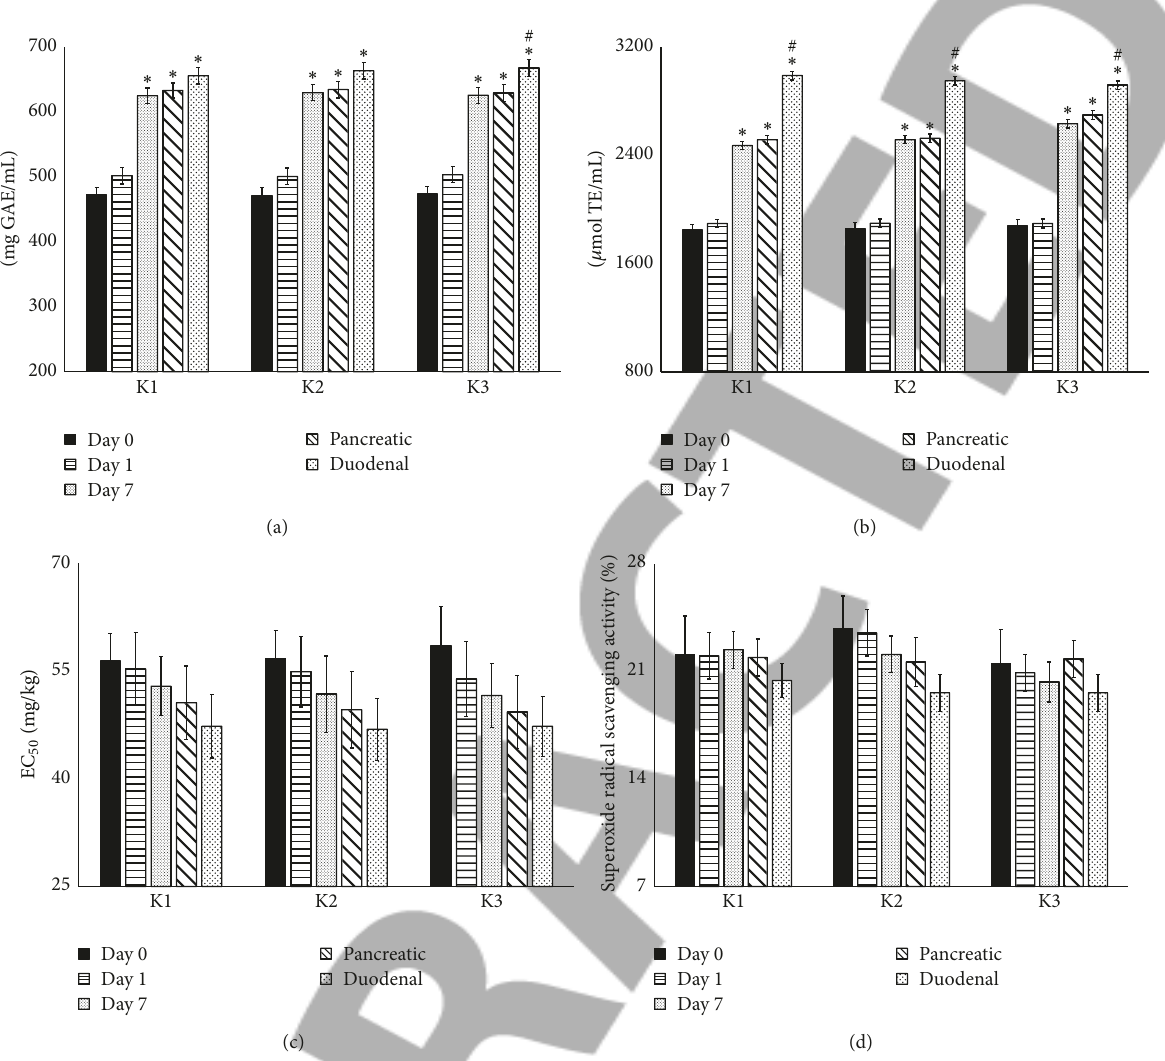
Figure 2: Changes in the (a) total phenolics content, (b) ORAC, (c) DPPH EC 50 , and (d) superoxide scavenging activities of the three Kombucha beverages. Error bars represent the SEM. ∗ 𝑃 < 0.05 versus the value at day 0. # 𝑃 < 0.05 versus the value at day 7 (prior to being subjected to the digestion